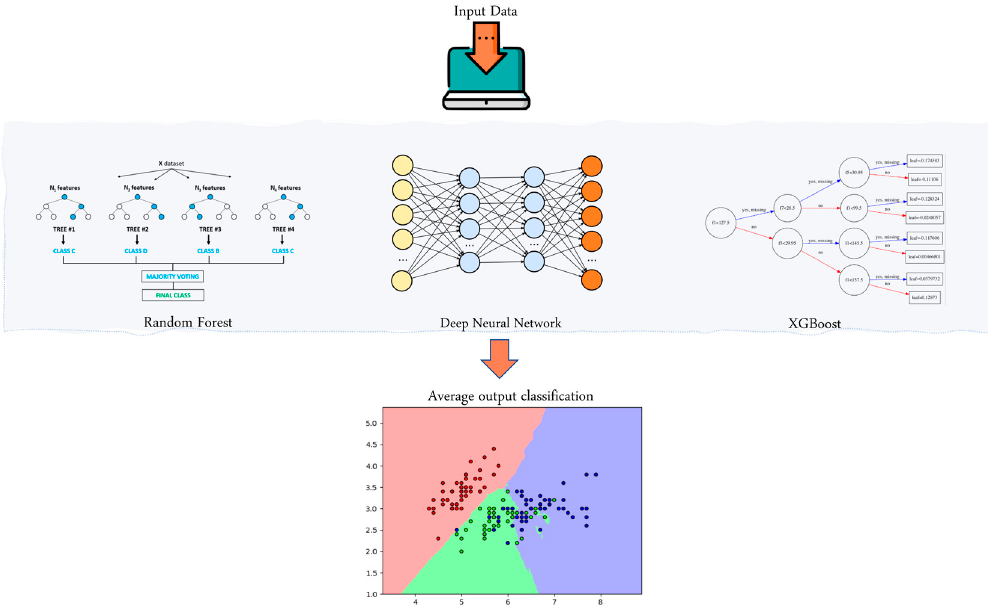
Figure 1. Proposed methodology: effort aware just-in-time prediction using deep ensemble method.